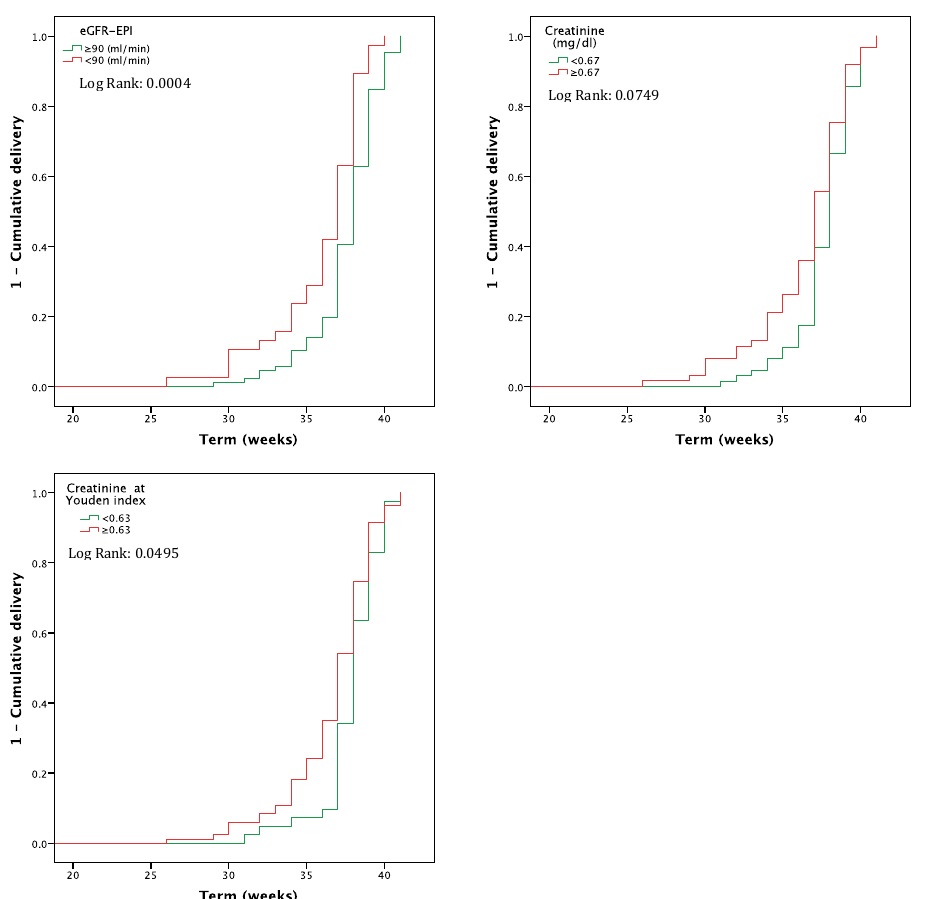
Figure 3. Timing of delivery in pregnancies from egg donation, according to serum creatinine (dichotomised at the median) and to e-GFR.